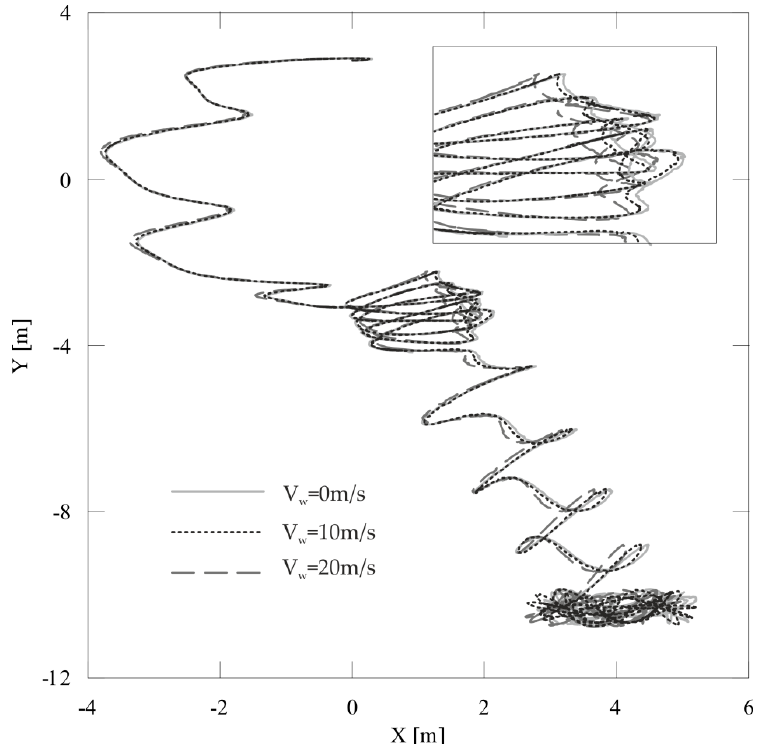
Figure 19. Trajectory projections of the carried load’s center of mass in the rotation plane (wind power having impact according to the direction of the X axis).